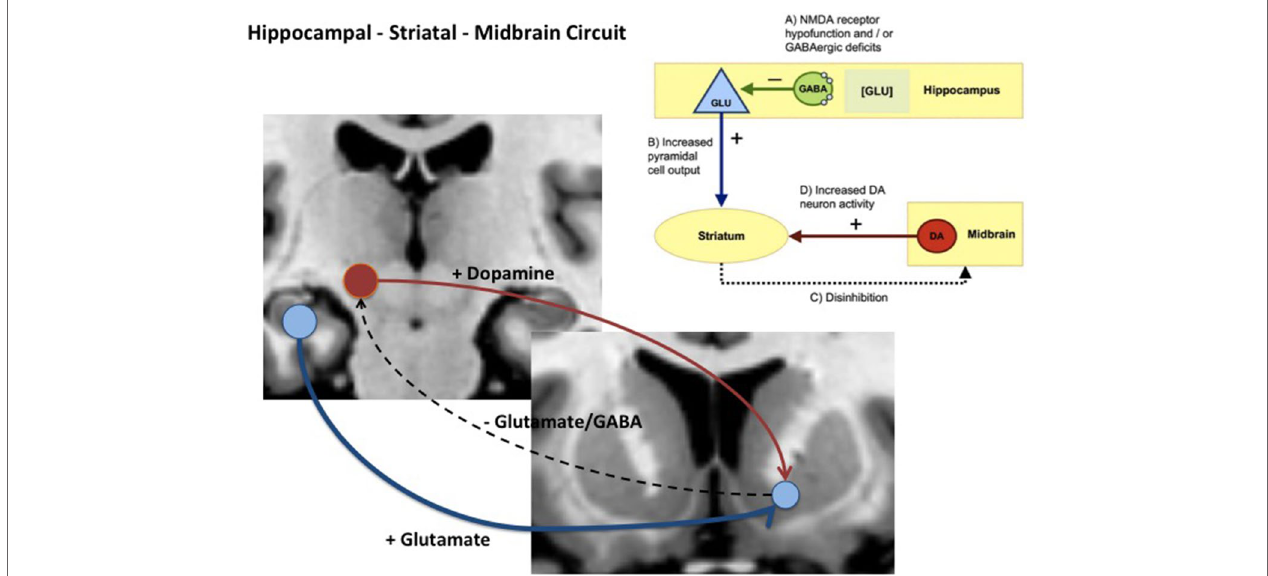
FIGURE 1 | Diagram showing hippocampal midbrain striatal circuit involved in the regulation of striatal dopamine via glutamatergic, GABAergic projections (+) = excitatory pathway and (−) = inhibitory pathway. In schizophrenia and clinical high-risk (CHR) states, it is hypothesized that increased glutamatergic output from the hippocampal subiculum to the ventral striatum (blue pathway) reduces inhibition via glutamatergic and GABAergic pathways that ultimately drives ventral tegmental area (VTA) dopamine cells and dopamine release back to the striatum (red